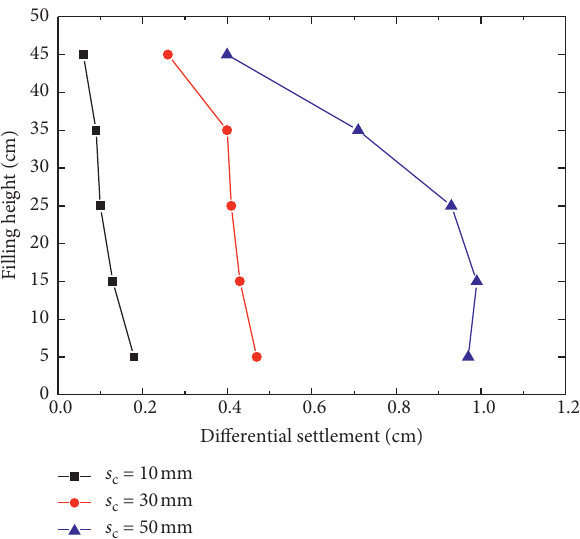
Figure 6: Variation of the differential settlement with filling height under different consolidation settlement conditions.